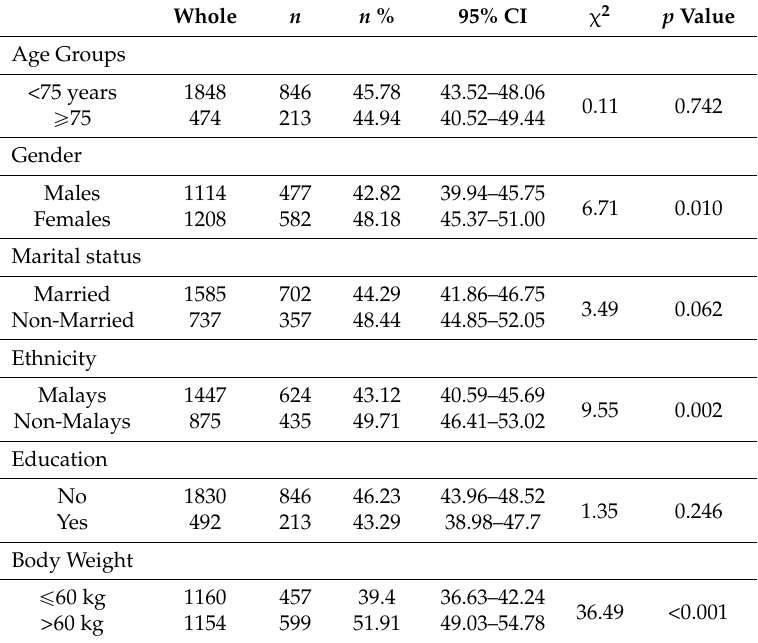
Table 2. Prevalence of hypertension and associations with socio-demographic